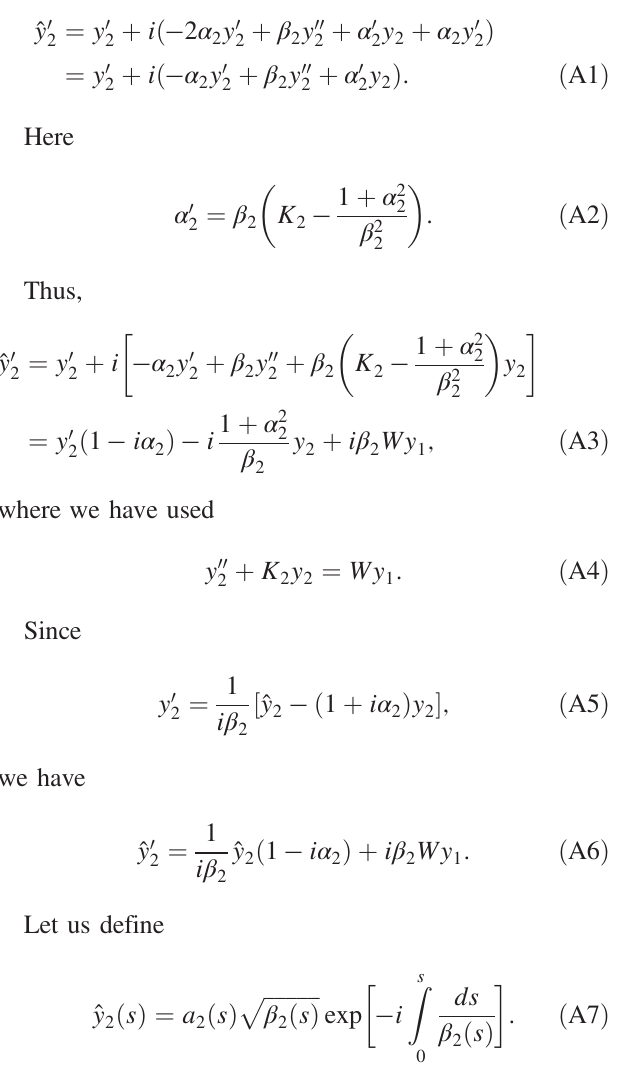
FIG. 25. The growth factor g × T to the two particle model. The blue and the green lines are for the ϒ ¼ 2 . 2 and ϒ ¼ 1 . 7 ,